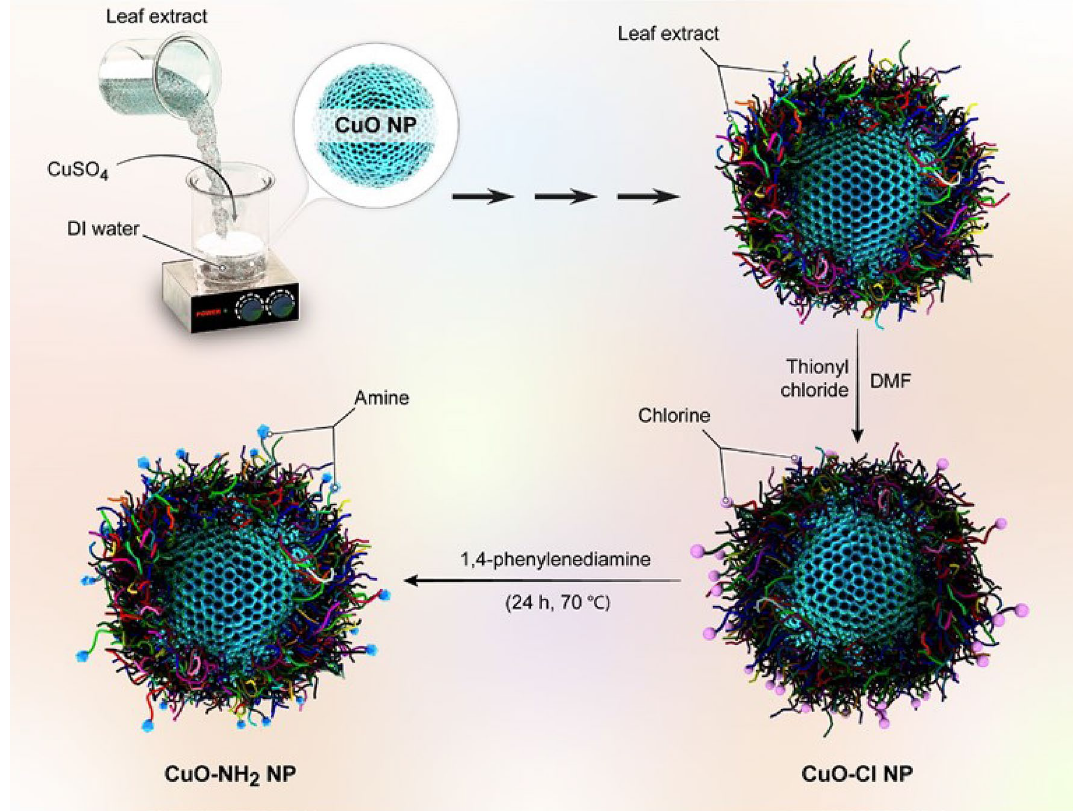
Figure 1. Schematic illustration for the synthesis of